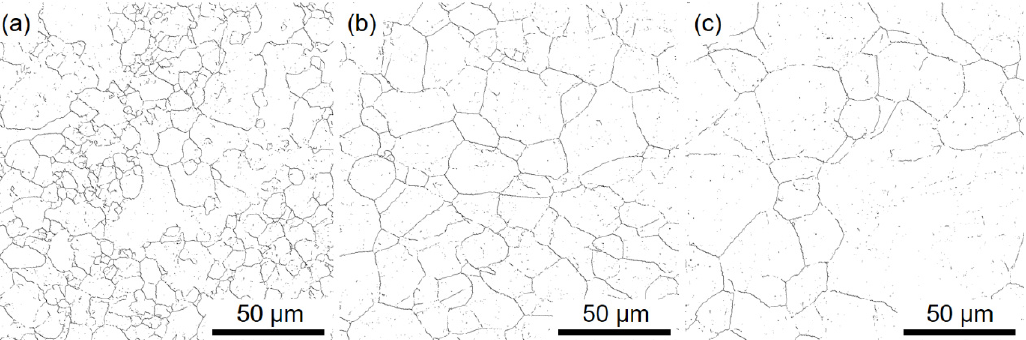
Figure 5. PAG boundary map of three experimental samples: ( a ) Q850, ( b ) Q950 and ( c ) Q1050.